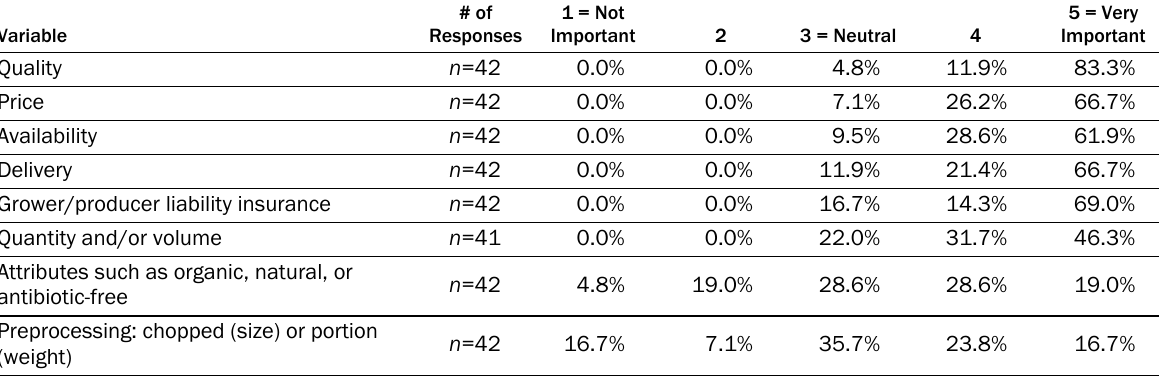
Table 8. Factors Non-users Rank as Most Important When Considering Local Foods